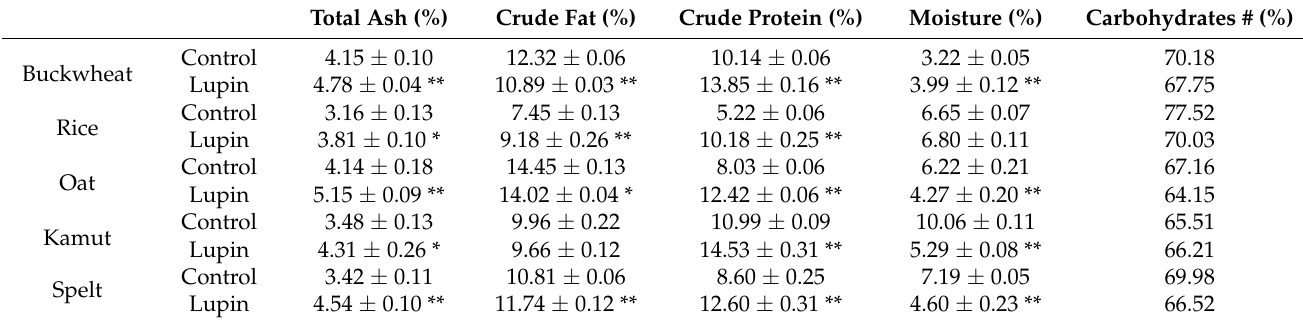
Table 2. Chemical compositions of five different flours with and without LE (%, dry weight). Results are expressed as averages ± standard deviation (n = 3). Note: * represents p < 0.05 and ** represents p < 0.001 when comparing LE cookies with the respective